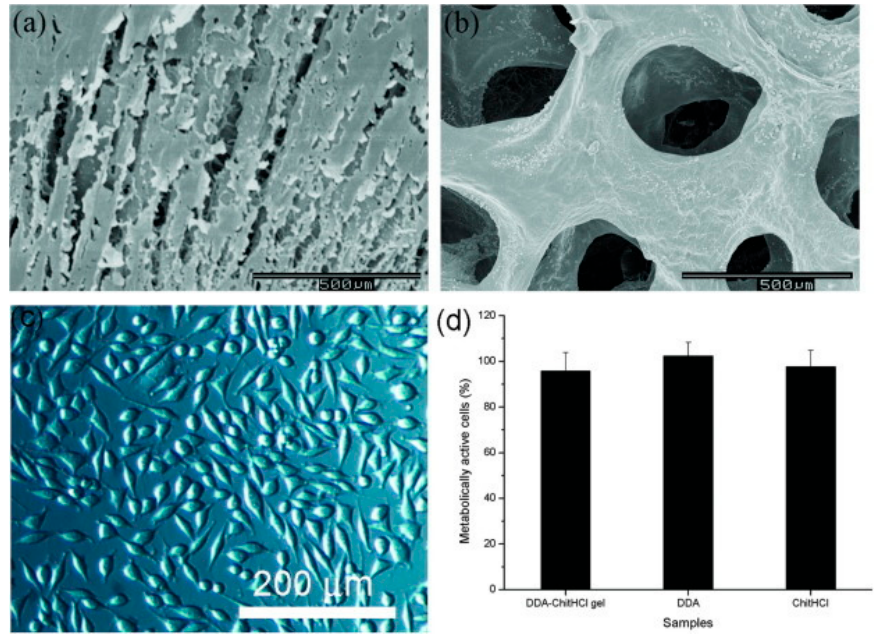
Figure 8. Scanning electron microscopy images showing ( a ) surface morphology and ( b ) internal structure of the representative lyophilized gel prepared using ChitHCl (5 wt%) and DDA50 (10 wt%); ( c ) optical microscope images of L929 mouse fibroblast cells exposed to gels ( d ) and variation in the percentage of metabolically active cells upon exposure to the gel extract and its components. Reprinted from Balakrishnan et al. [20]. Copyright (2017), with permission from Elsevier.